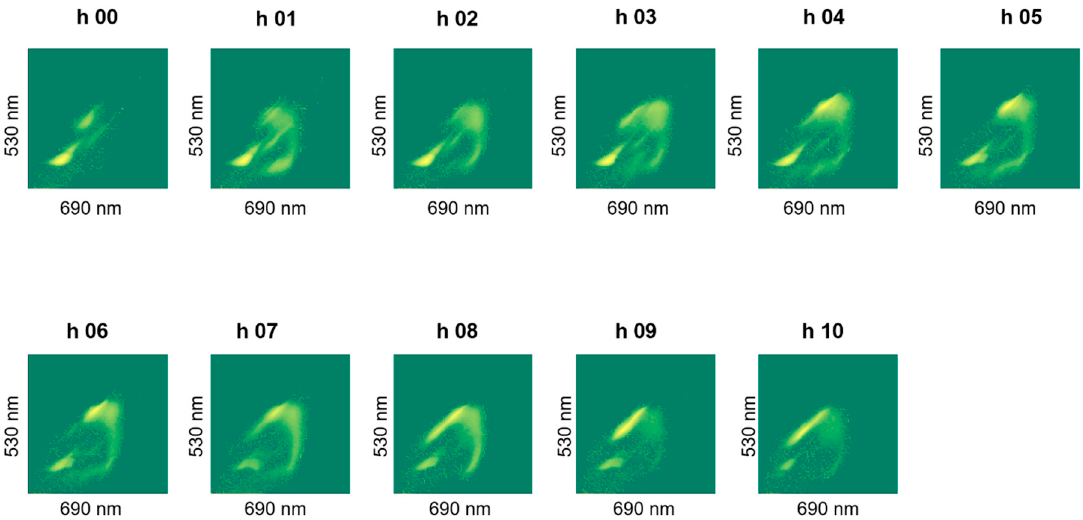
Figure A1. Plot of FL 1 against FL 2 fluorescence intensities of hourly samples showing dynamics of clusters observed during fermentation for pH-A (2) batch.